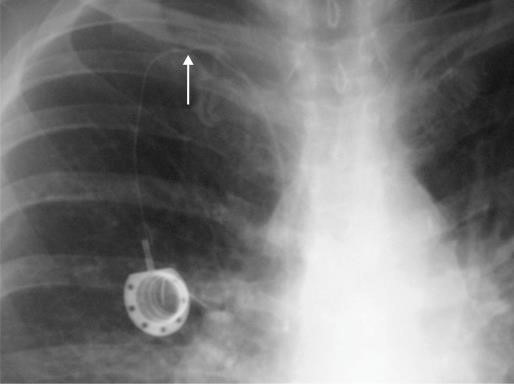
Constriction of the catheter (arrow) in the space between the clavicle and the first rib.